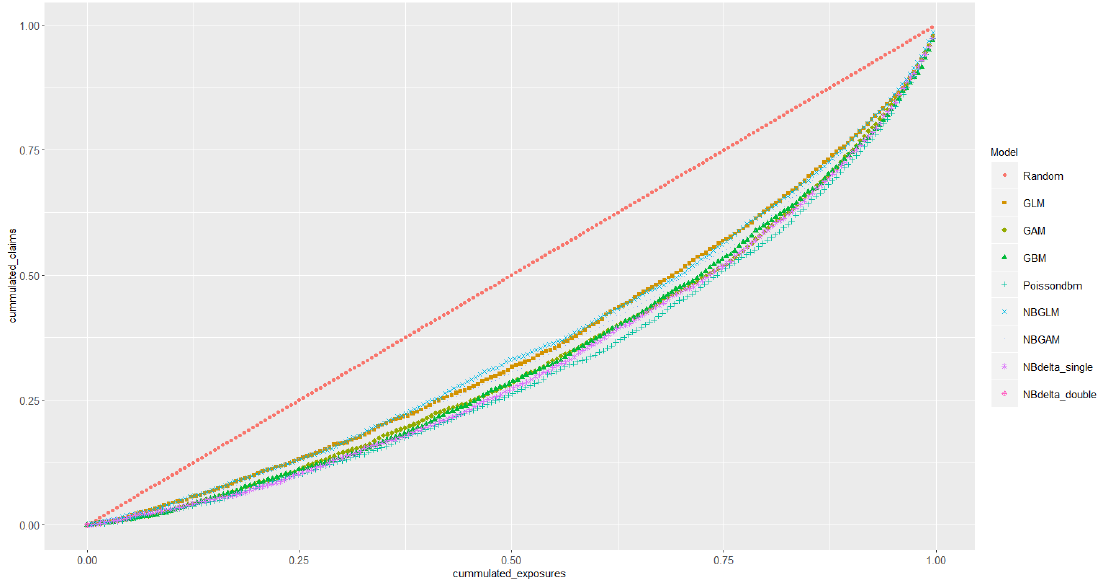
Figure 2. Lorenz curve for candidate